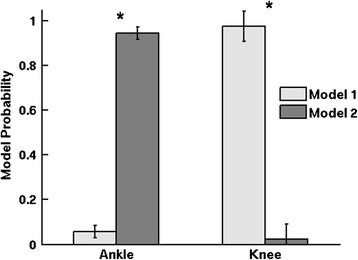
AMICA model probabilities for ankle trials (left) and knee trials (right). Error bars show 1 SD. * p < 0.01.